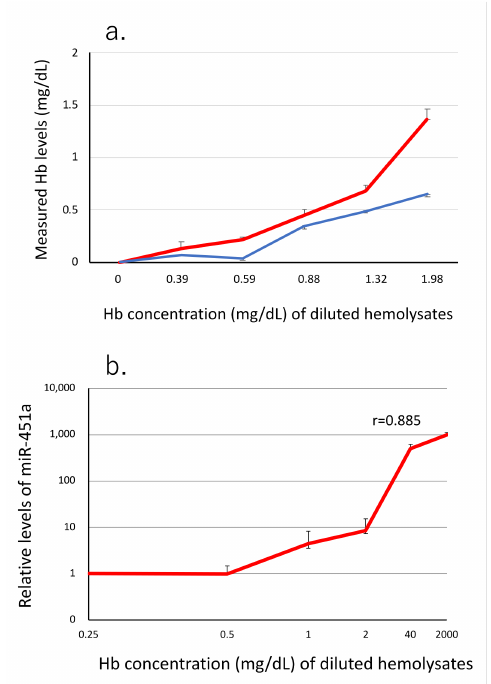
Figure 1. Sensitivity of miR-451a for hemolysis. ( a ) Comparison of sensitivity to detect Hb between the oxyhemoglobin method (red line with SEM bar, n = 3) and the optical densitometry method (blue line). Measurement was conducted using sequentially diluted hemolysates with the concentration of 0.39 to 20 mg/dL of hemoglobin. Asterix indicates statistically significant elevation from the blank level ( p < 0.05). ( b ) miR-451a assay to detect hemolysis: Relative values of measured levels of miR-451a correlated well with Hb concentration (r = 0.885, n = 3, bar: